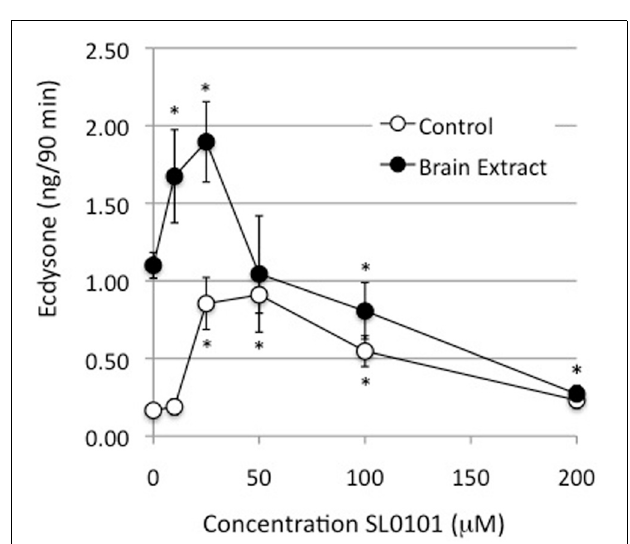
equivalents/30ul), brain extract + U0126 (BE + U) or brain extract + LY294002 (BE + LY). (A) Results of a typical experiment. (B) Quantification of Western blots. Asterisks indicate groups that were statistically different than Controls (ANOVA, Tukey–Kramer post-hoc test, p < 0 . 05). n = 4–16 samples per group.